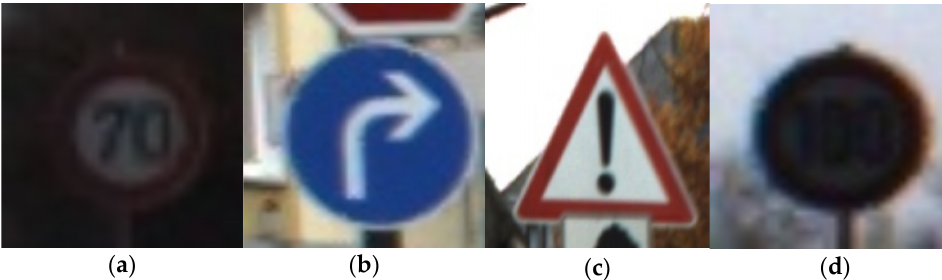
Figure 3. Examples of input images from the test dataset, where ( a ), ( b ), ( c ), traffic signs without occlusion, ( d ) occluded traffic sign.